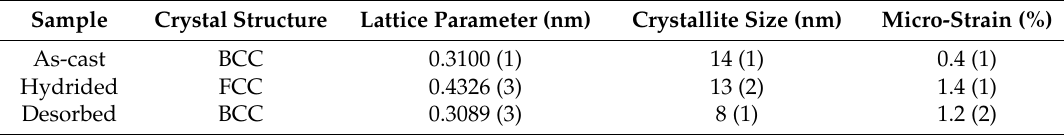
Table 2. Crystal parameters of the co-melt Ti 1.56 V 0.18 (FeV) 0.18 Cr 1.08 + 4% Zr 7 Ni 10